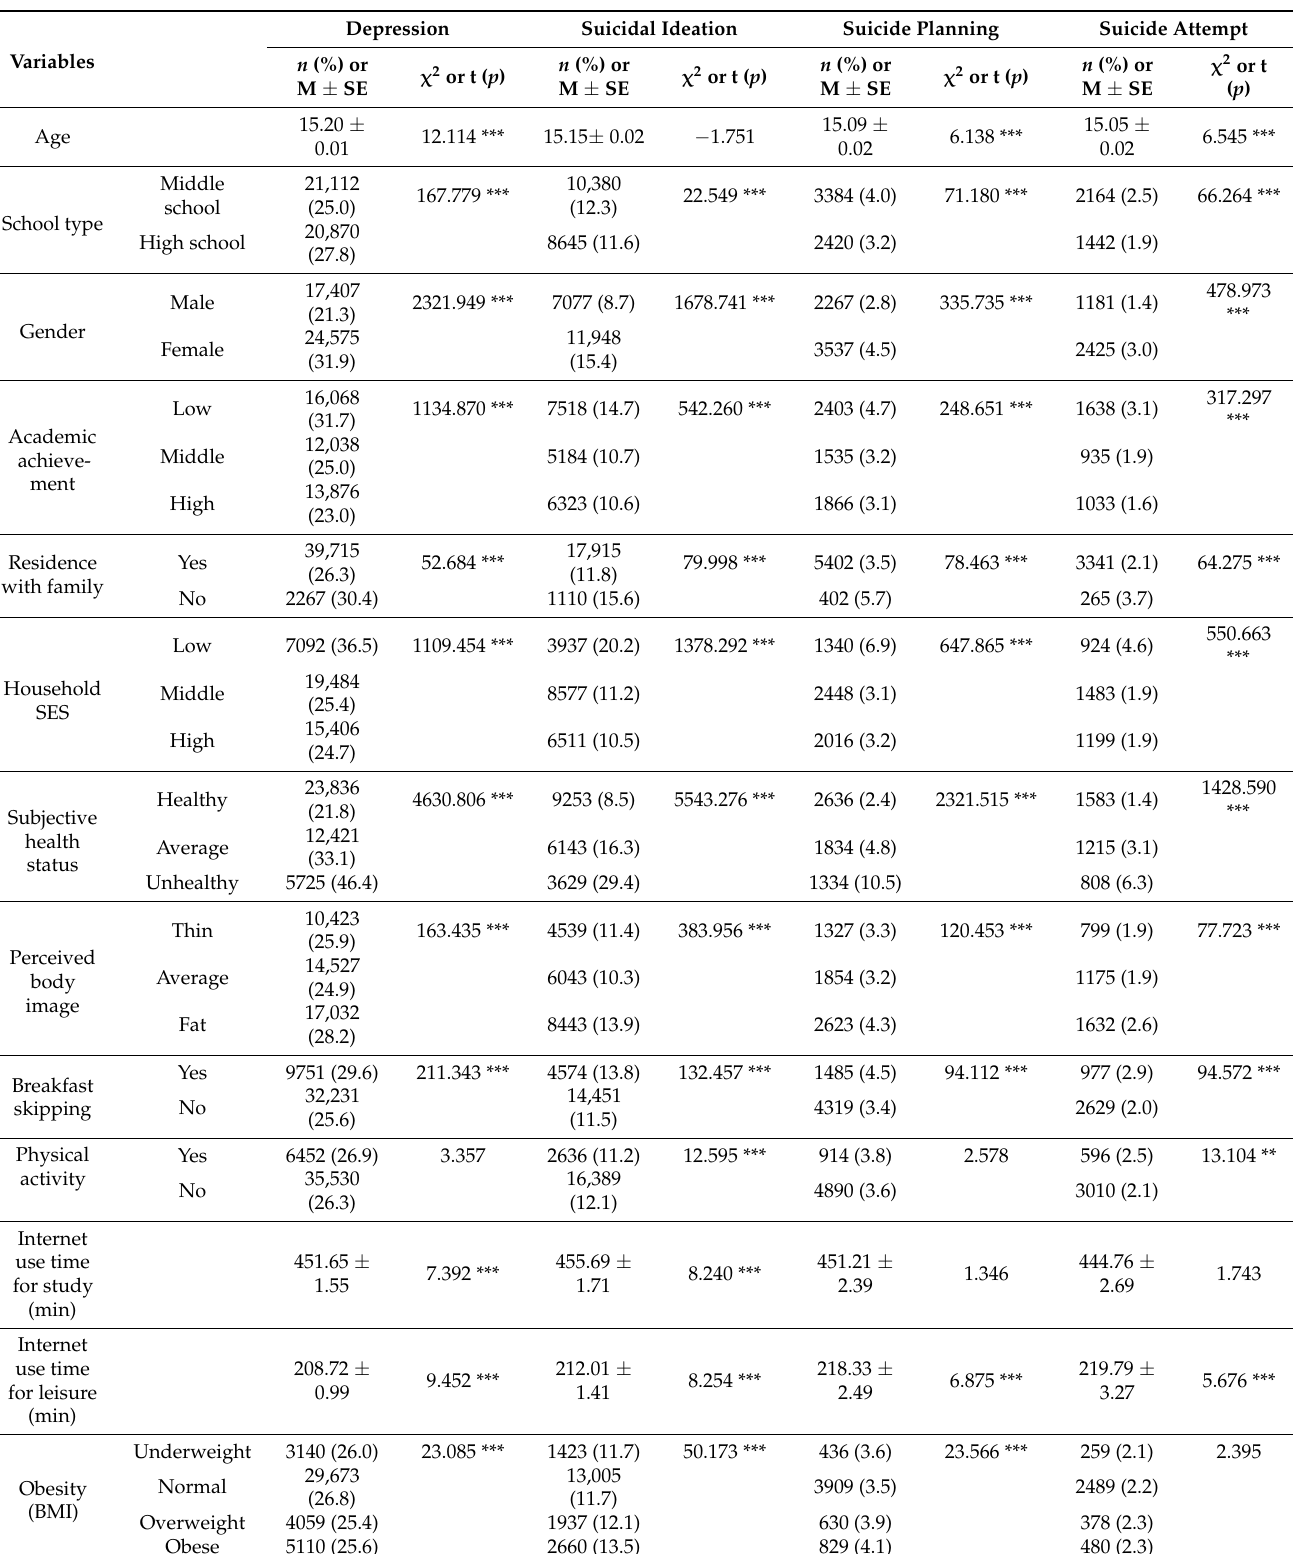
Table 3. General and health-related characteristics according to the suicide-related characteristics ( N =